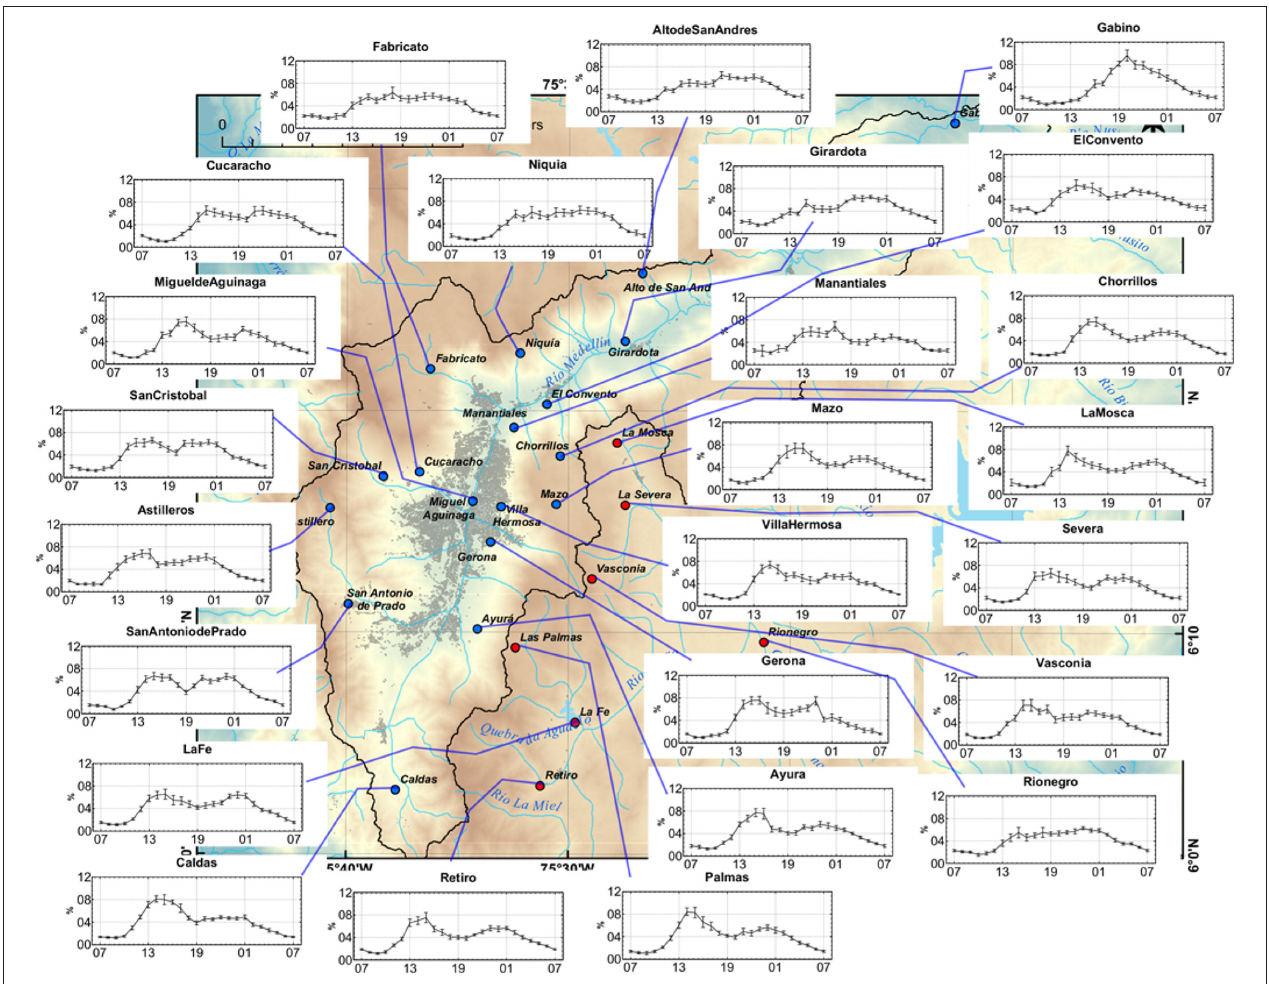
FIGURE 3 | Long-term mean (1998–2005) diurnal cycle of percent rainfall (with respect to daily total) of raingauges in the study region (Equation 2). Error bars on all panels represent the standard error of the mean. Computations based on hourly series excluding zeros. Blue (red) points in the map represent the raingauges located on the Aburrá Valley (San Nicolás